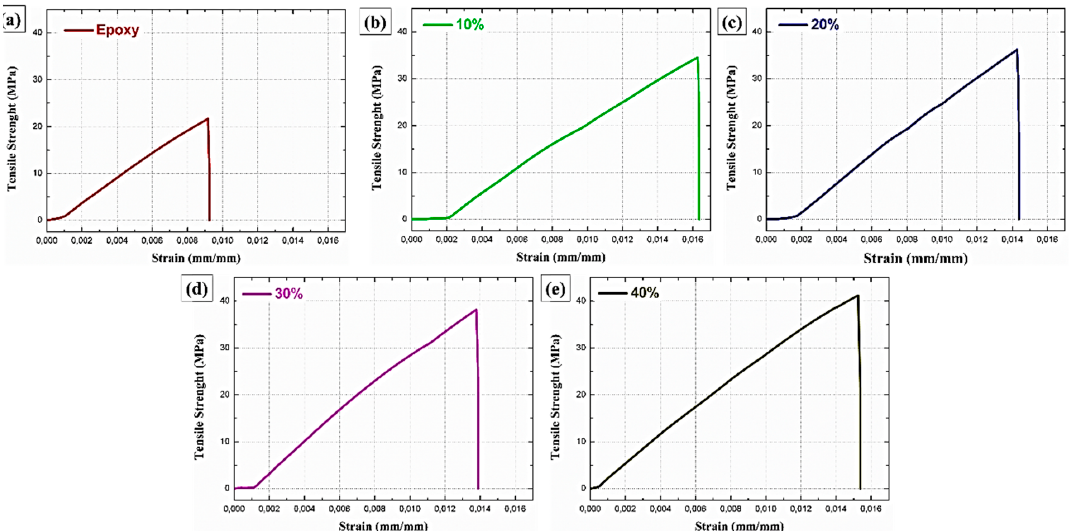
Figure 7. Stress-strain curves for the neat epoxy resin and composites reinforced with carnauba fibers. ( a ) Neat epoxy, ( b ) 10, ( c ) 20, ( d ) 30, and ( e ) 40 vol%.